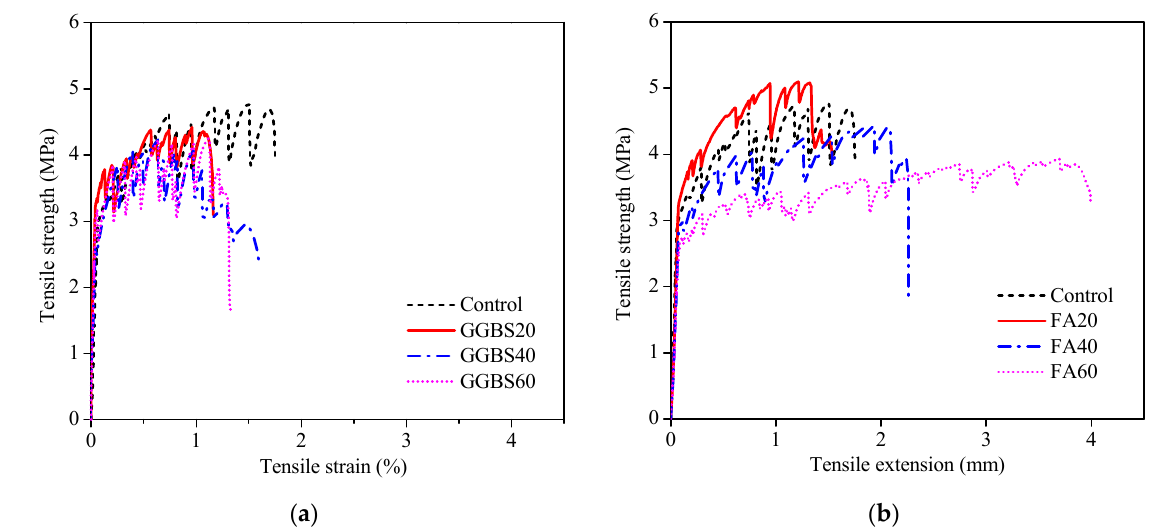
Figure 10. Typical tensile stress–strain curves of ULHS-ECCs with ( a ) GGBS; and ( b ) FA substitutions.